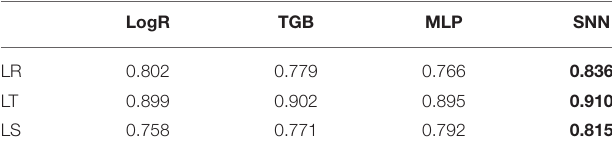
TABLE 3 | Comparison among classification